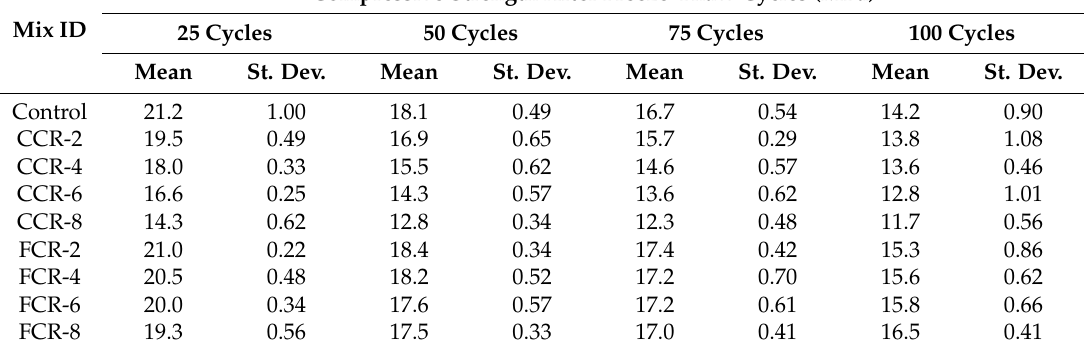
Table 6. Freeze–thaw results of RMPC.